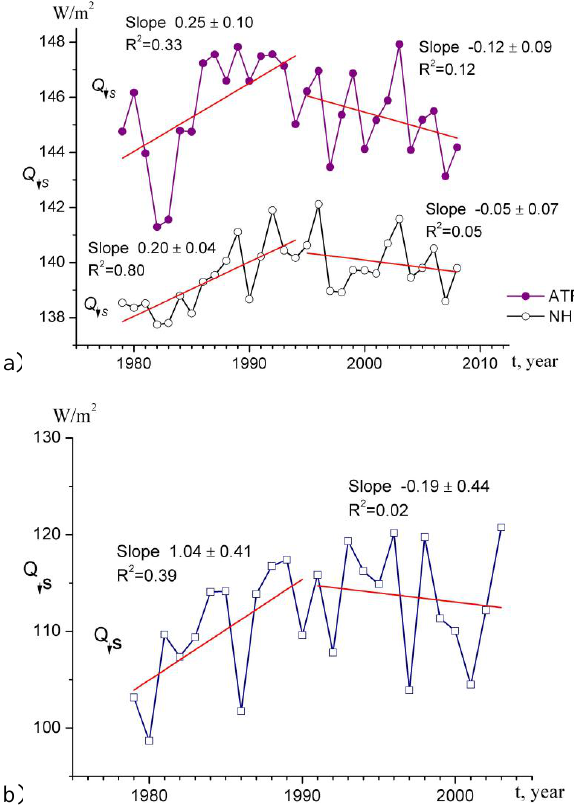
Fig. 3. The temporal variability of downward shortwave radiation at the surface Q ↓ s by JRA-25 for the period of 1979–2008: zonally Figure 3. The temporal variability of downward shortwave radiation at the surface Q  S by 2 averaged values from 50 ◦ to 60 ◦ N over ATR and Northern Hemi- JRA-25 for the period of 1979-2008: zonally averaged values from 50° to 60°N over ATR 3 and Northern Hemisphere (a) and at Aleksandrovskoe station (60  26  N. 77  52  E) (b). 4